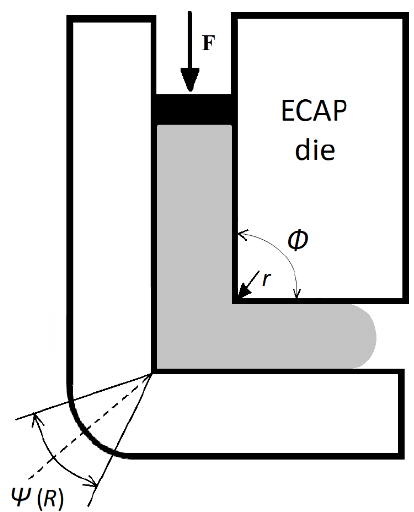
Figure 2. Diagram of the ECAP die used [28].